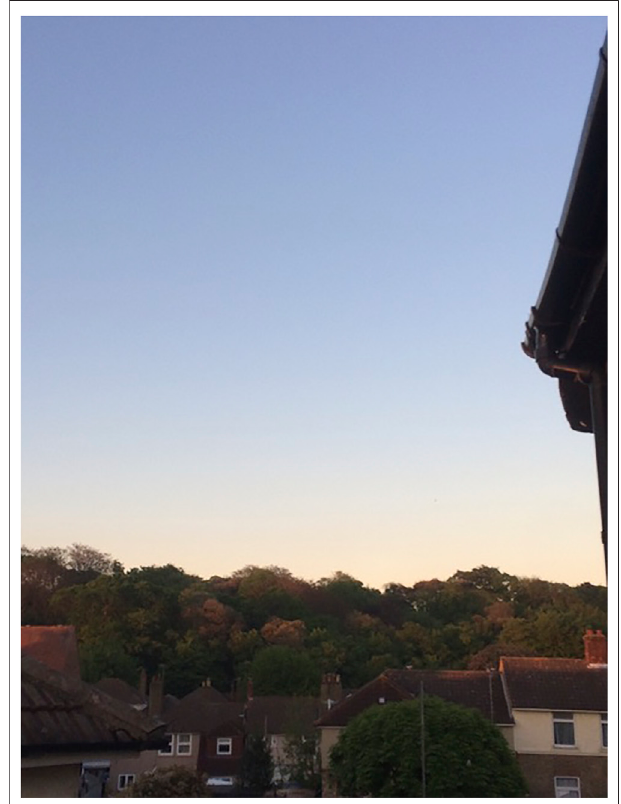
FIGURE 3 | “ A view outside my window at the Micro Rainbow shelter. Forever grateful after escaping homelessness. ”